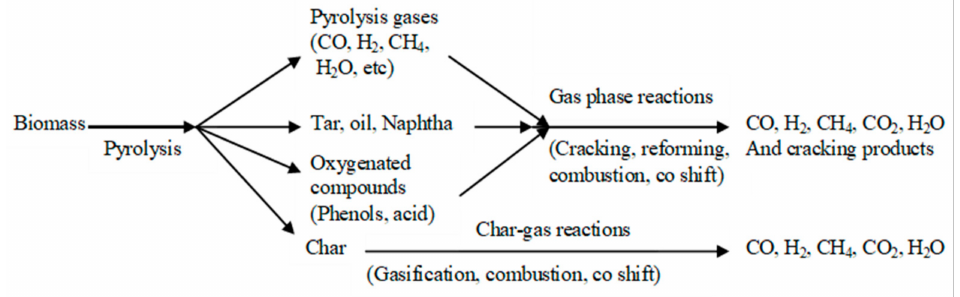
Figure 1. Reaction sequence for gasification of biomass